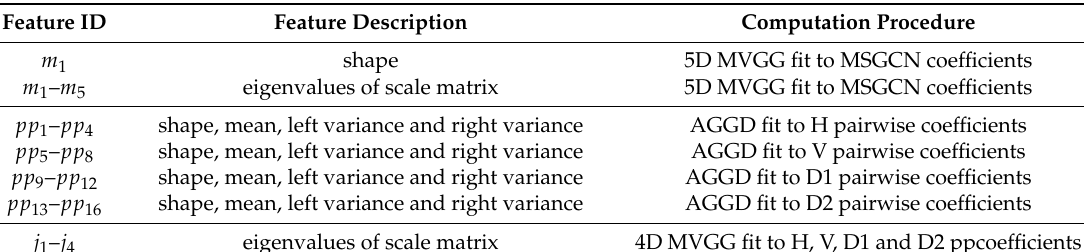
Table 1. Feature summary of joint MSGCN( m ), paired-products ( pp ) and joint paired-products ( j ) coefficients. All features are extracted at two